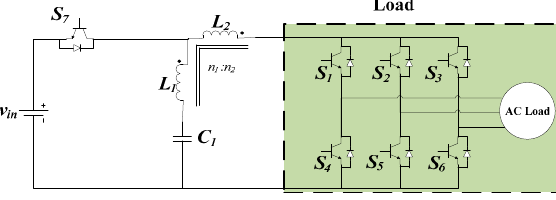
Figure 7. Bidirectional Γ -source inverter topology.